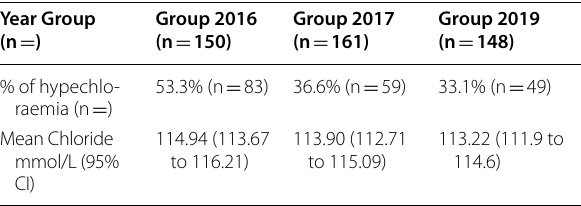
Table 1. Hyperchloraemia over year